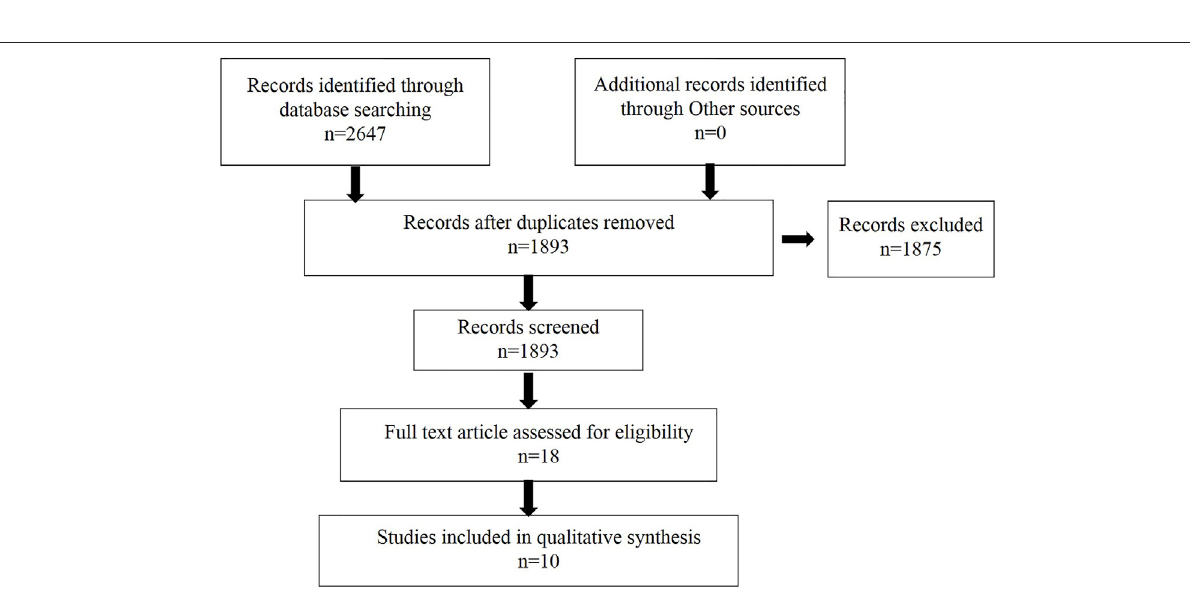
Frontiers in Pharmacology |